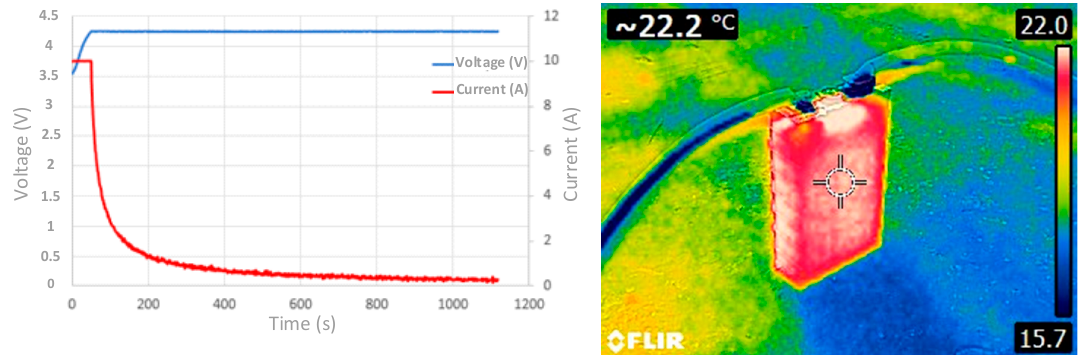
Figure 2. Waveforms of charging current and voltage during overcharging concerning for 4.25 V of charging voltage level.